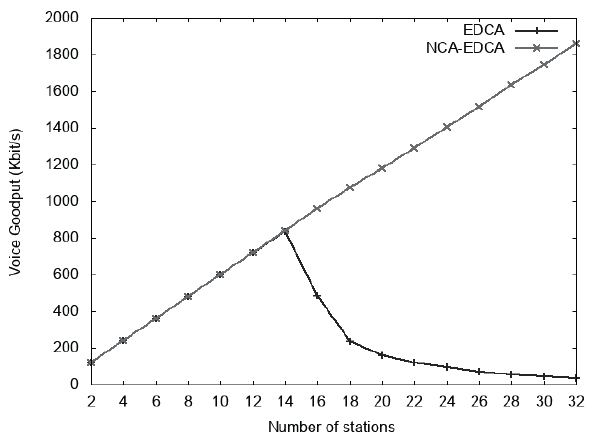
Fig. 7. EDCA and NCA-EDCA voice goodput.